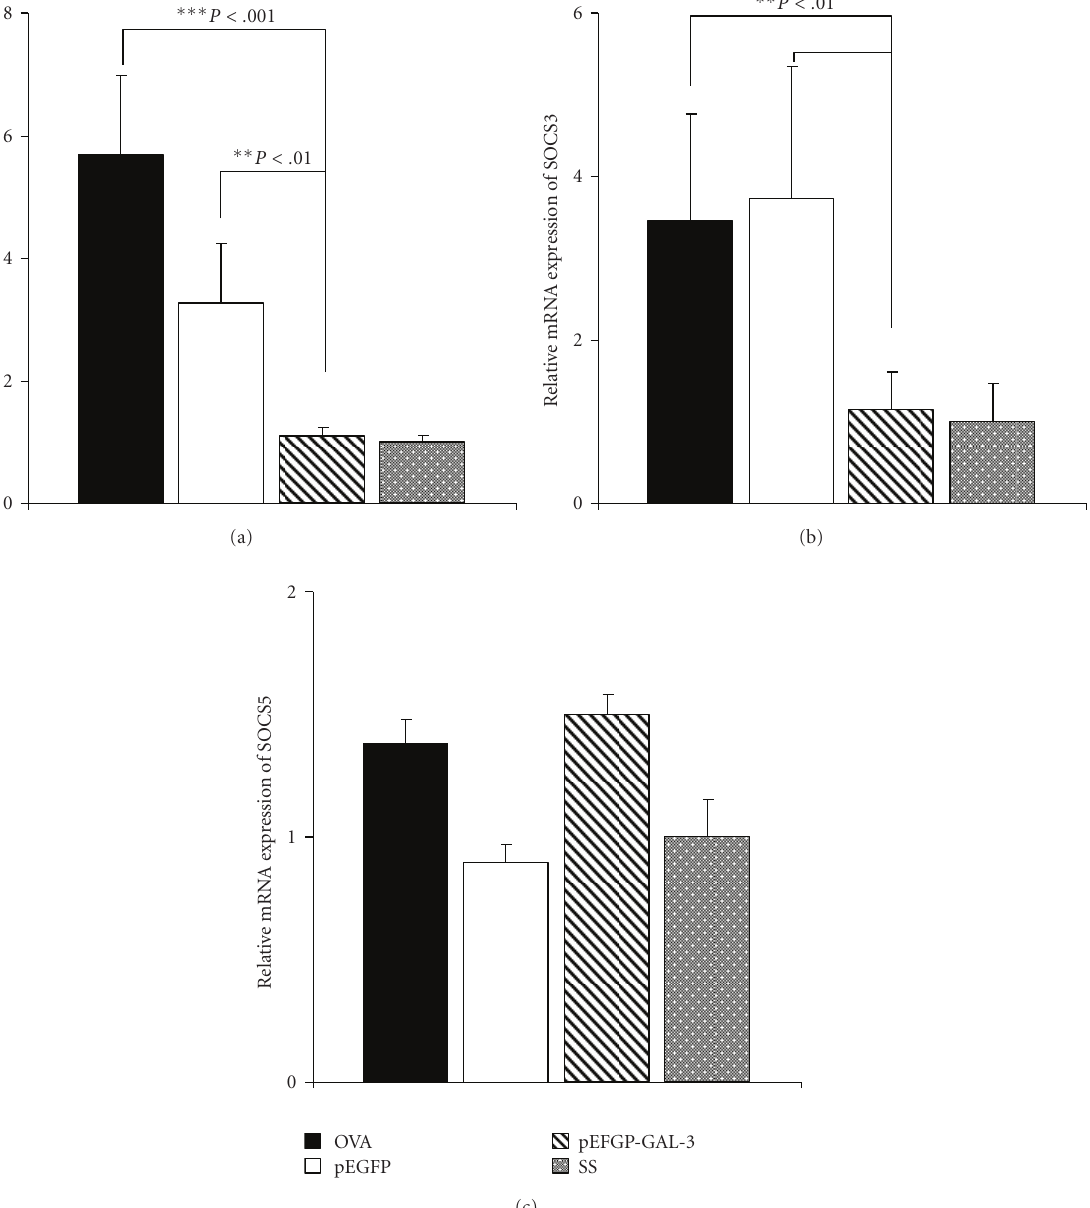
Figure 2: Semiquantitative expression of SOCS1, SOCS3, and SOCS5 genes in lungs after twelve weeks of OVA exposure. Relative mRNA levels of SOCS1 (a), SOCS3 (b), and SOCS5 (c) gene expression in lungs of di ff erent groups of mice were determined by real-time quantitative PCR. Values were normalized with rRNA gene used as endogen. Black bars represent the OVA group ( n = 15), white bars the pEGFP group ( n = 15), shaded bars the pEGFP-Gal-3 group ( n = 20), and gray bars the SS group ( n = 10). The results show relative gene expressions, as determined by the ΔΔ C T method, after twelve weeks of antigen exposure. Significant di ff erences in SOCS3 and SOCS1 ( ∗∗ P < . 01 and ∗∗∗ P < . 001) expression levels were obtained for the pEGFP-Gal-3 versus the OVA and pEGFP groups.